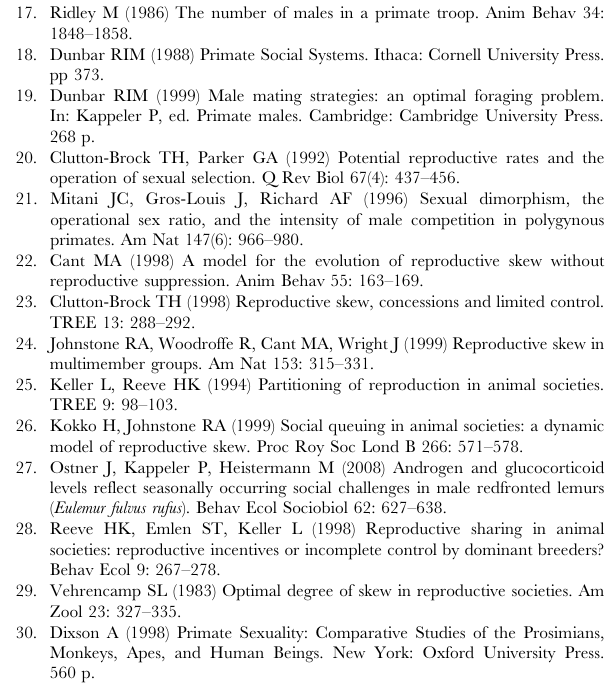
Table S1 Data used in the Carnes et al. analysis of the effects of the distribution of female primates on the number of